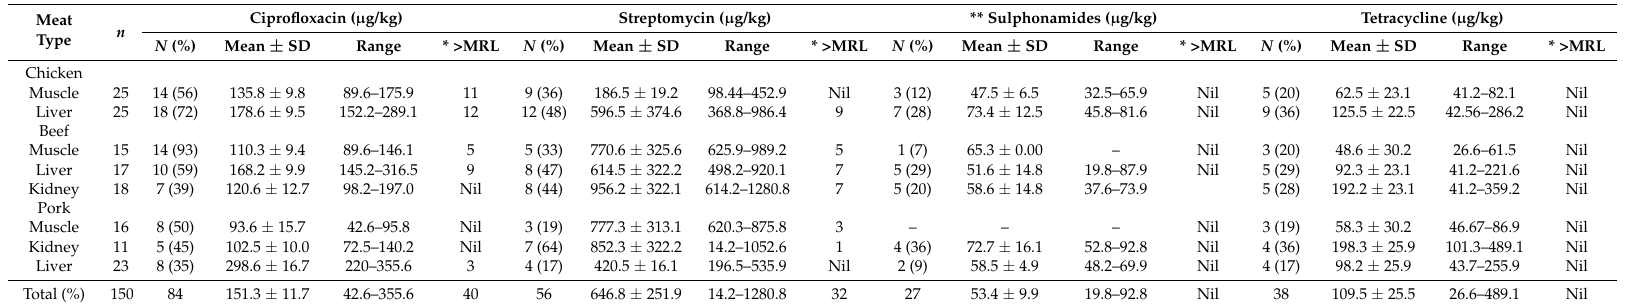
Table 2. Mean concentration of antibiotic residue in meat samples using the ELISA